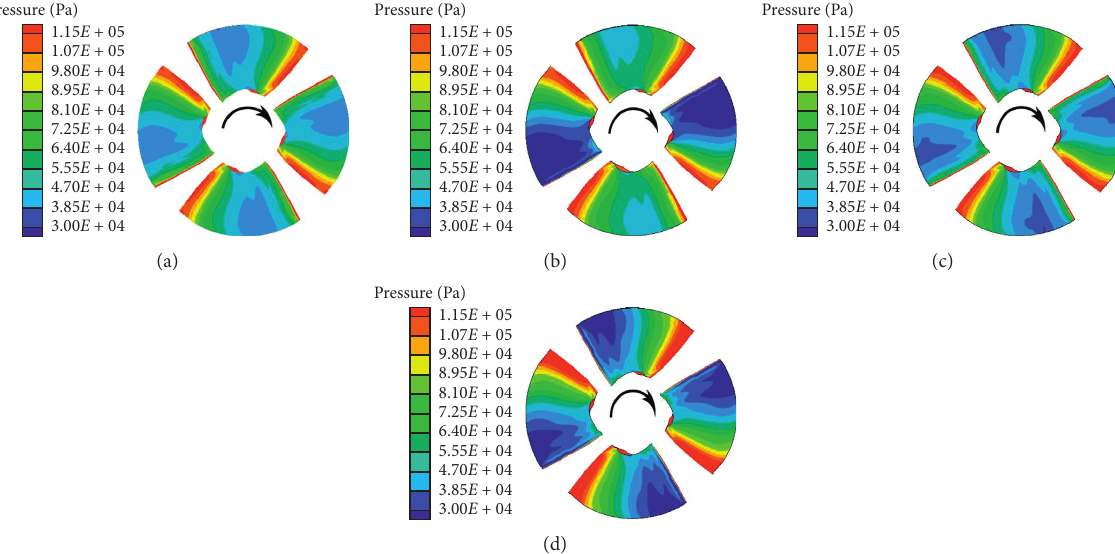
Figure 10: Pressure distribution of impeller suction surface in different schemes ( Q � Q Scheme